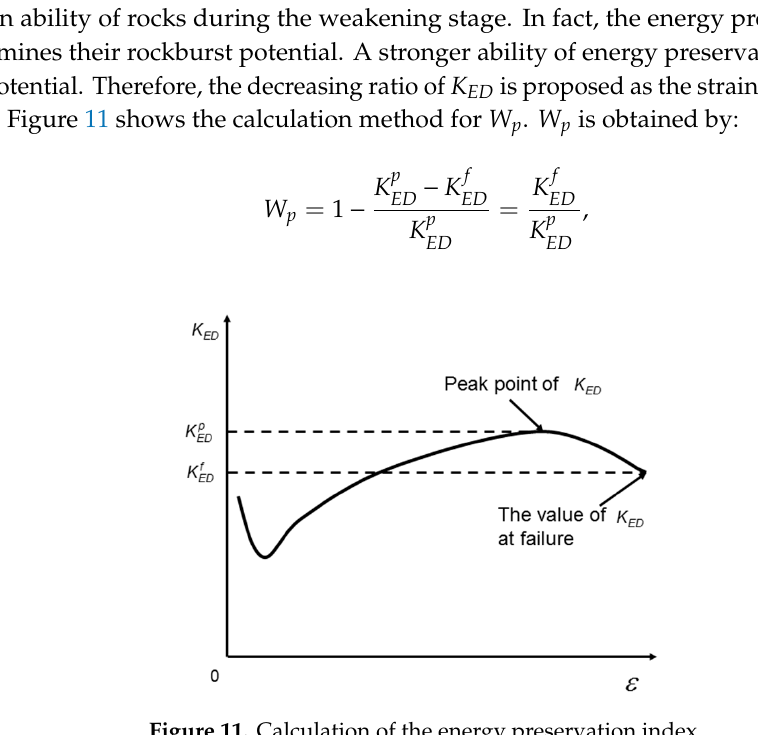
K ) for the rocks. Figure 10. Evolution of the ratio of elastic strain energy to dissipated energy ( K ED ) for the rocks. ED